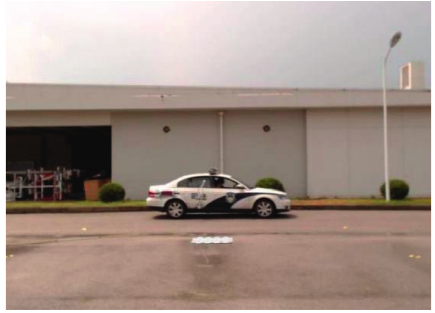
Figure 5: Images corrected in distortion.